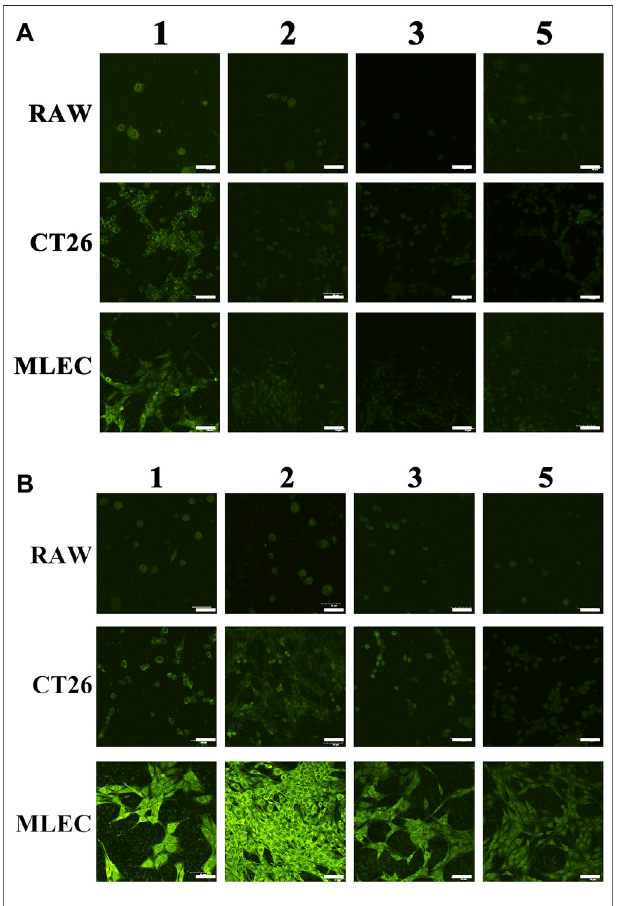
FIGURE 3 | Staining effect of ICG (A) or ICG@HMONs-HA (B) on three kinds of cells. The numbers 1, 2, 3, and 5 in the picture represent the cleaning of cells for 1, 2, 3, or 5 times after staining. The scale bars equal 50 μ m.